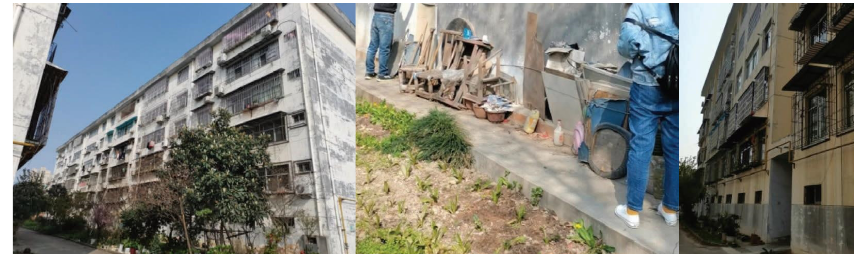
Figure 10: Current situation of the old residential area of industrial and commercial Bank of China.